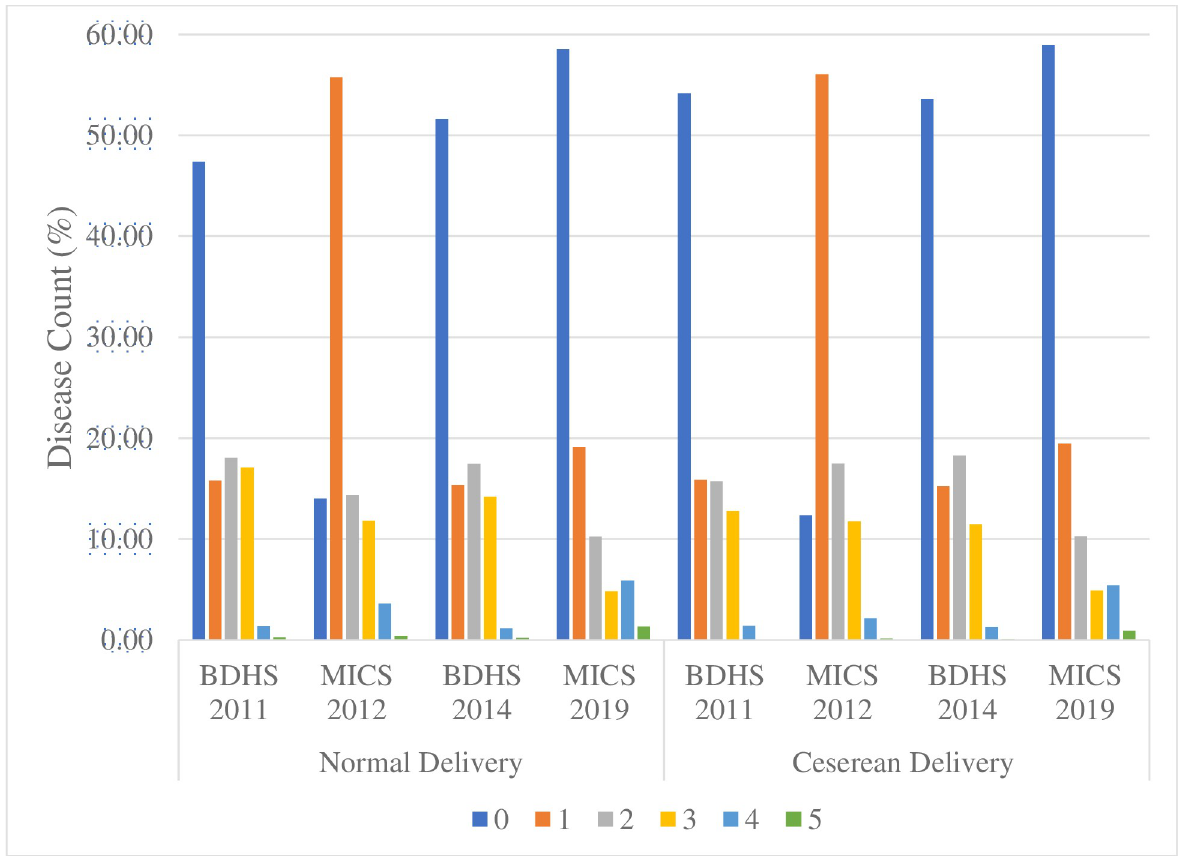
Fig 1. Distribution of common childhood disease by delivery type and survey